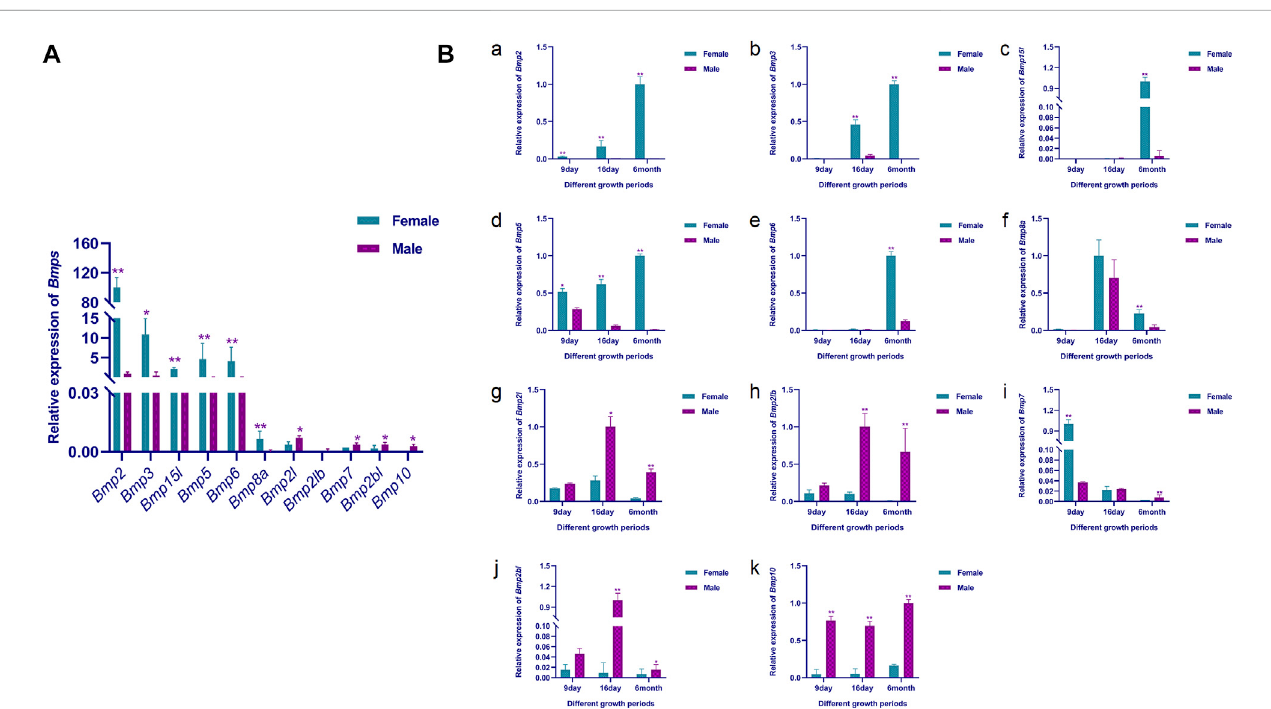
FIGURE 11 qRT-PCR validation results. (A) . Relative expression of BMPs in the male and female gonads of the 6-month-old P. sinensis . (B) . Relative expression of BMPs in male and female gonads at different developmental periods (A – K) Represent the relative expression of Bmp2 , Bmp3 , Bmp15l , Bmp5 , Bmp6 , Bmp8a , Bmp2l, Bmp2lb , Bmp7, Bmp2bl and Bmp10 in gonads at different developmental stages, respectively.11